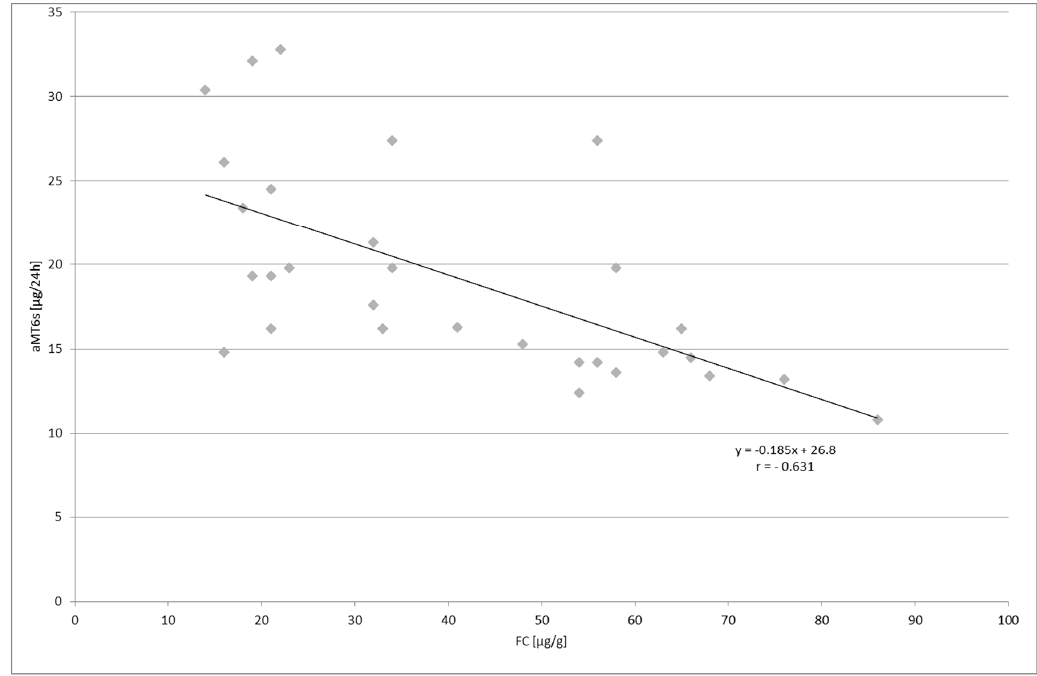
Figure 7. Correlation between fecal calprotectin (FC) concentration and urinary 6-sulfatoxymelatonin (aMT6s) excretion in patients with lymphocytic colitis; p < 0.01.